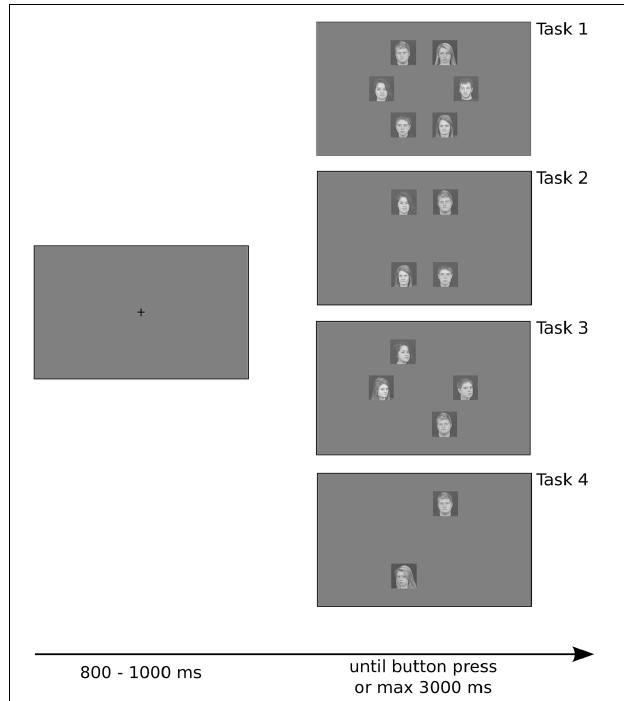
FIGURE 1 | Example of trials with different number of stimulus array used in the experiment. Stimuli were positioned on a circle, separated by 60 ◦ from each other, making them equidistant from the fixation point and lying on a regular hexagon. Note that for set sizes of two and four there are three possible shapes that the stimuli can create (rotations of 60 and 120 ◦ of the shape depicted here), which were randomly chosen from trial to trial. See details in the